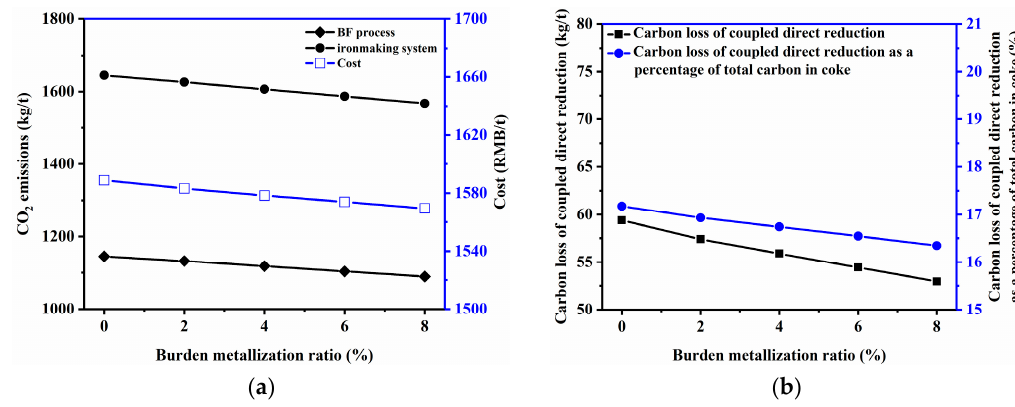
Figure 6. ( a ) Effect of burden metallization ratio on cost and CO 2 emissions; ( b ) Effect of burden metallization ratio on carbon loss of coupled direct reduction and its percentage of total carbon in coke.